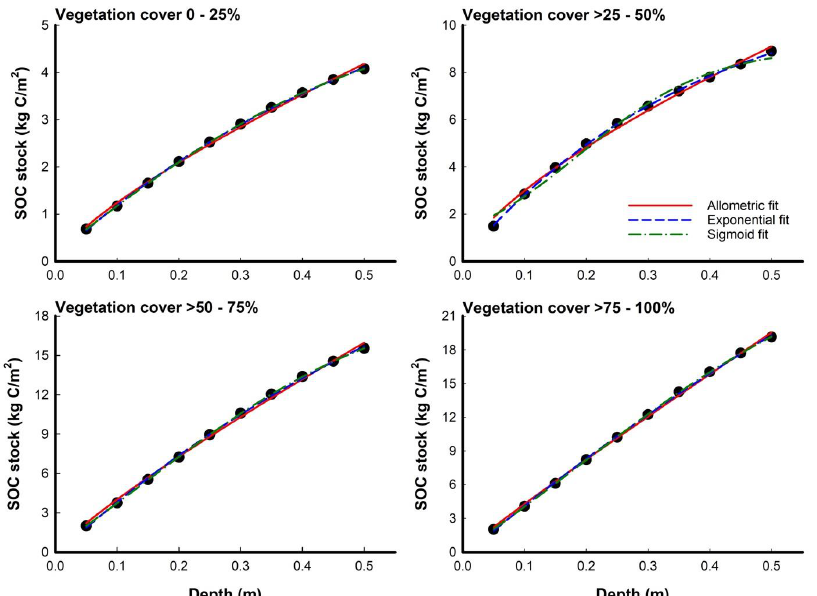
Figure 4. Fitting curves between cumulative soil organic carbon (SOC) stock (kg C/m 2 ) and soil depth using three functions in ten sites of sabkhas with different vegetation covers along the southern Red Sea coast of Saudi Arabia. F Vegetation cover = 1238.8 ***; F Depth = 413.3 ***; F Vegetation cover x Depth = 41.5 ***; F -values represent the two-way analysis of variance (ANOVA); ***: p < Table 3. Model parameters and fitting results of volumetric soil organic carbon (SOC) density (kg C/m 3 ) using three functions in ten sites of sabkhas with different vegetation covers along the south- ern Red Sea coast of Saudi Arabia.